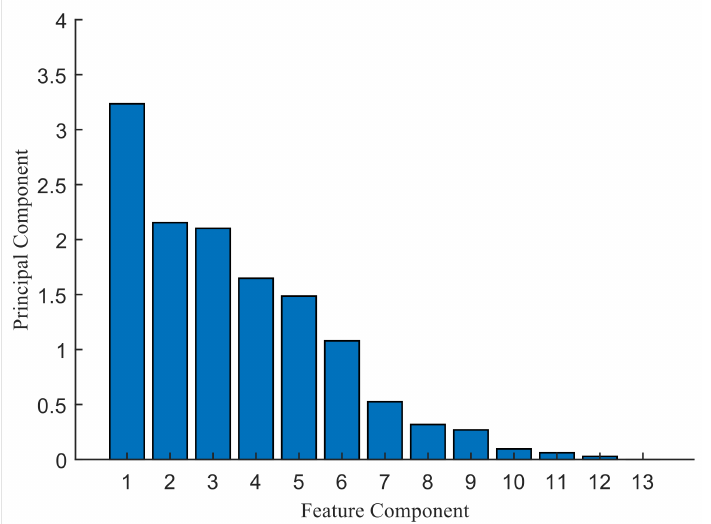
Figure 5. SSA and principal component